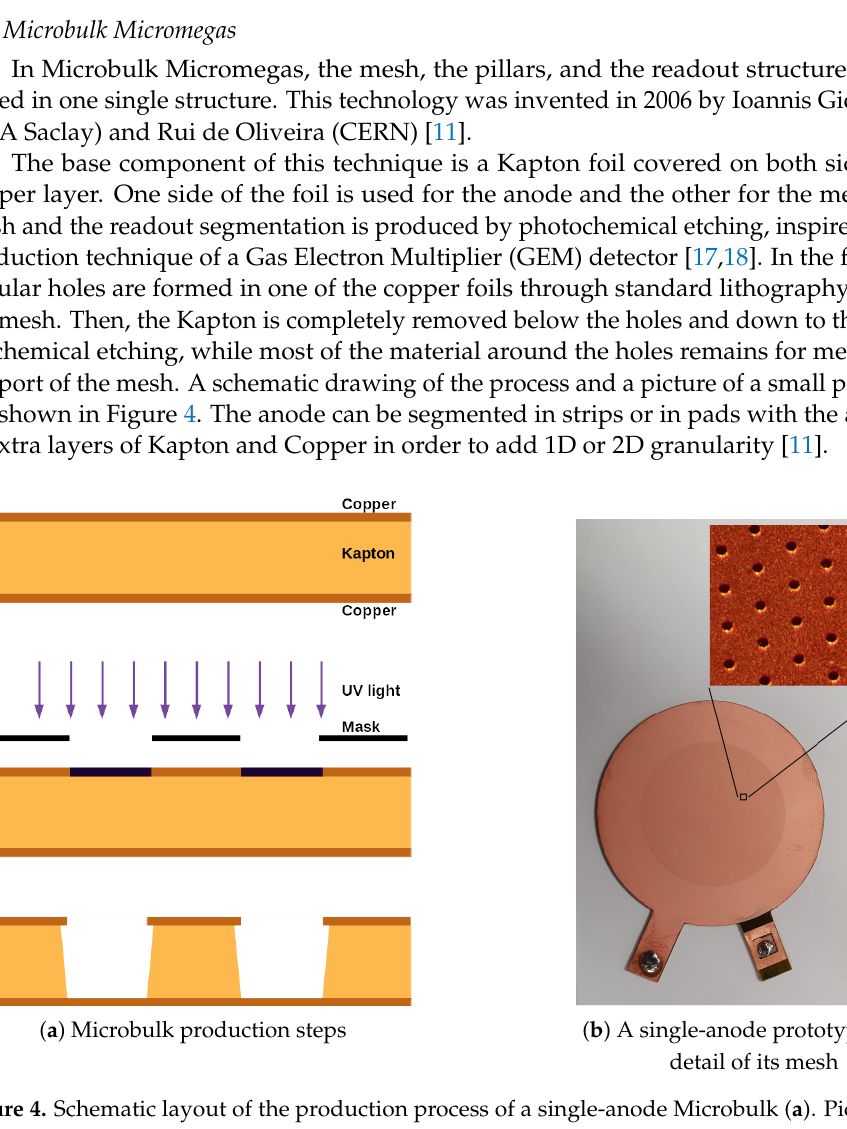
Figure 4. Schematic layout of the production process of a single-anode Microbulk ( a ). Picture of a Microbulk prototype and a microscope view of the mesh ( b